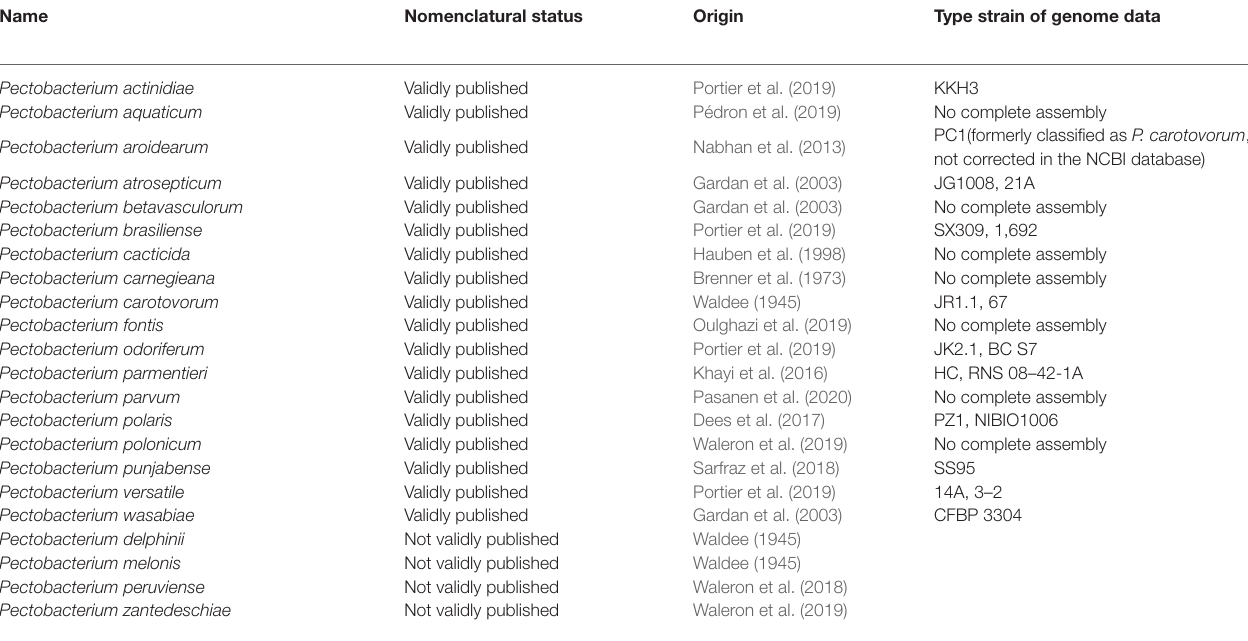
TABLE 1 | Nomenclatural status and type strain of genome data of the Pectobacterium